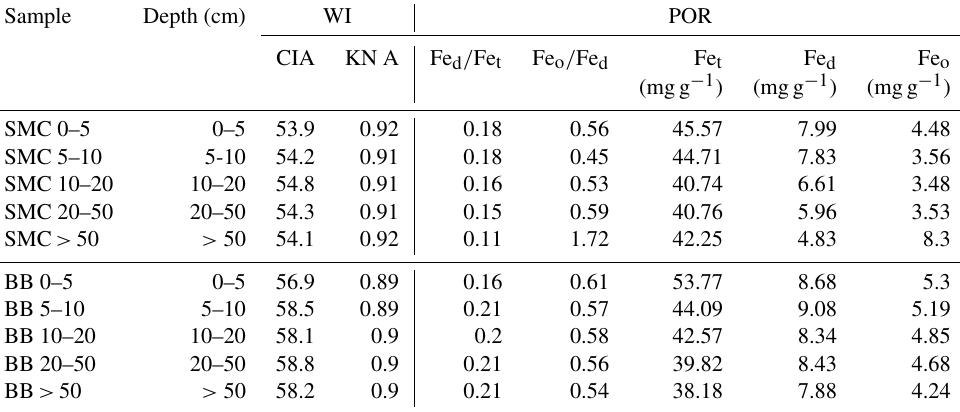
Table 2. Weathering indices (WI) and pedogenic oxide ratios (POR) of two soil profiles from Santa Martha Cove (SMC) and Brandy Bay (BB) from James Ross Island, Antarctica. CIA: chemical index of alteration; KN A: Kronberg–Nesbitt index; Fe d : dithionite-soluble iron; Fe t : total iron; Fe o : oxalate-soluble iron. Sample Depth (cm) WI POR CIA KN A Fe d / Fe